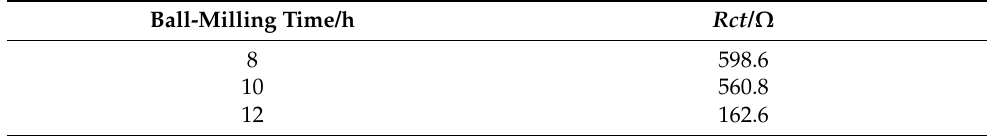
Figure 6. AC impedance spectrum of mixed oxide after sintering. Table 1. Impedance values of mixed oxides after sintering.